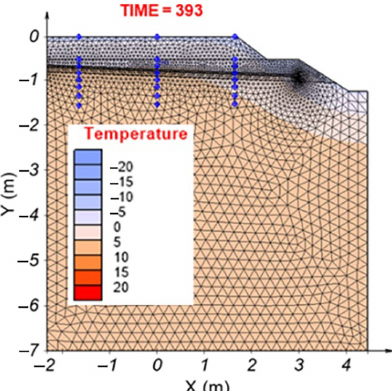
Figure 5. The day of reaching the maximum freezing value of the railway track structure ( D F = 0.656